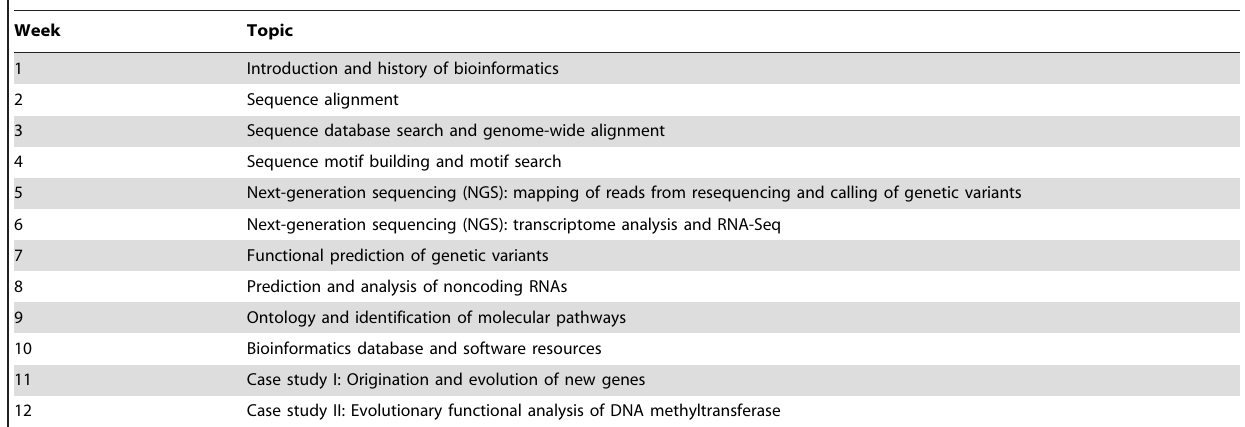
Table 1. Syllabus of the MOOC ‘‘Bioinformatics: Introduction and Methods.’’